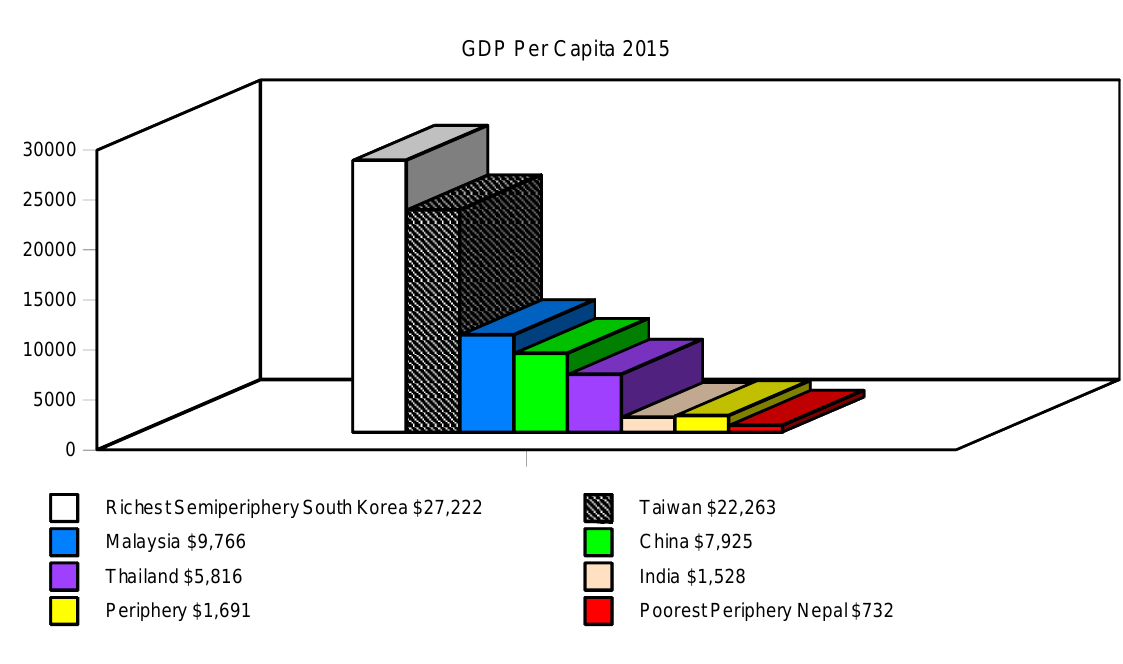
Part B. Inequality within Nonwestern Regional Tiers of the